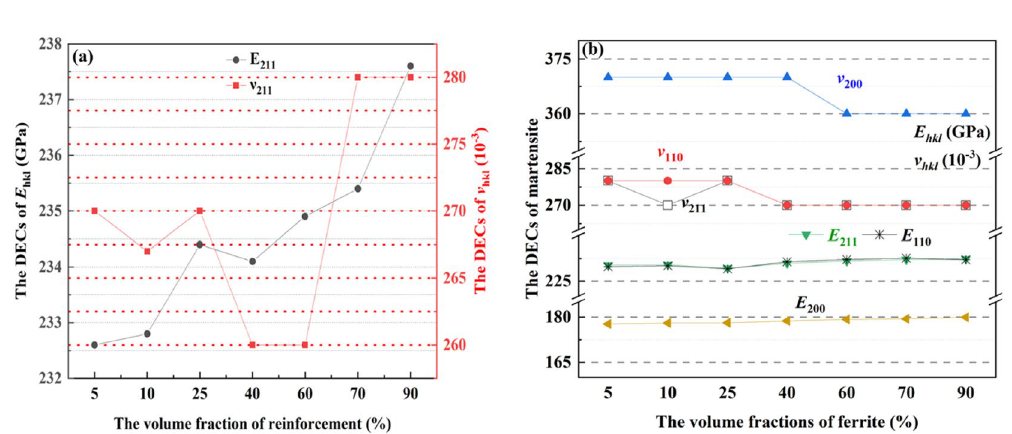
Figure 6. DECs of constituents as a function of reinforcements ( a ) DECs of the ferrite; ( b ) DECs of the